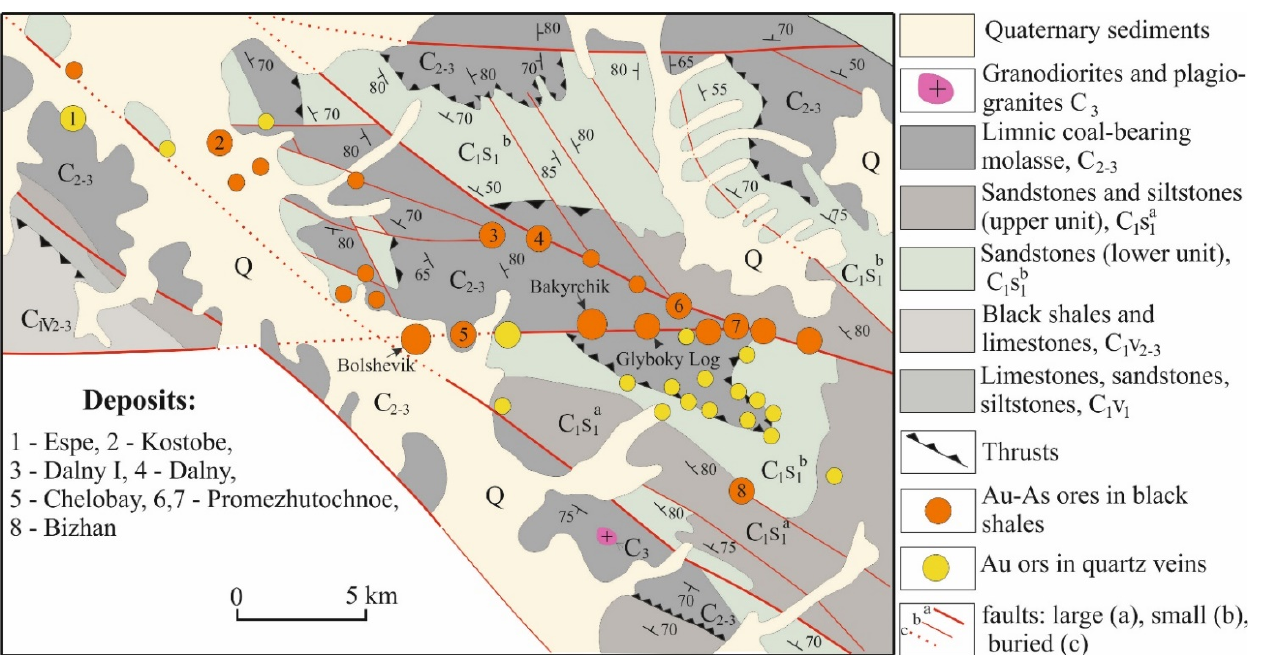
Figure 11. Metasomatic ( a ) and geochemical ( b ) zoning of the Bakyrchik ore field [58]. 1 = coal ‐ bearing sediments; 2 = shear zones: thrusts ( a ) and other faults ( b ); 3–7 = sericite (3), tourmaline (4), chlorite ‐ albite (5), carbon ‐ kaolinite ‐ sercite (6), and carbon ‐ sericite (7) metasomatism, 8 = serici ‐ te ‐ phlogopite ‐ carbonate; 9 = contour of the ore field in the projection on the vertical plane; 10 ‐ 11 = established (10) and proposed (11) centerlines of ore deposits; 12 = geochemical zones.